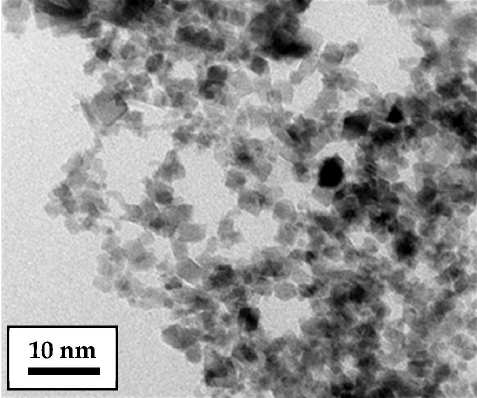
Figure 1. Representative agglomerated nanostructure of CeO 2 doped with 1.00 mol % Fe (metal basis) fabricated by flame spray pyrolysis (FSP) at >1300 °C and log p(O 2 ) = − 0.15.